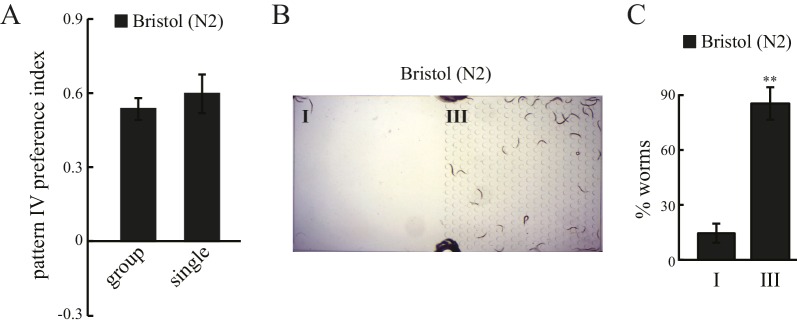
Spatial pattern selectivity is an individual behavior that relies on mechanosensation and spatial context.(A) Spatial pattern selectivity is not a social behavior. ‘Single’ – A single N2 worm was loaded into the quad-chamber, and its location was recorded at 60 min. Twenty chambers with single worms were analyzed each time, and experiments were repeated four times. ‘Group’ – A group of twenty N2 worms was loaded into a quad-chamber each time, and experiments were repeated four times. Percentage of worms in pattern IV at 60 min was plotted, and error bars indicate s.e.m. (B) A representative image showing N2 worms in a chamber containing only two patterns; one with no pillars (same as pattern I in the quad-chamber), and the other with the same design as pattern III. (C) N2 worms show preference for pattern III at 60 min after loading, indicating that pattern preference depends on relative rather than absolute pillar density. n = 5; **p<0.01; Student’s t test. error bars denote s.e.m.